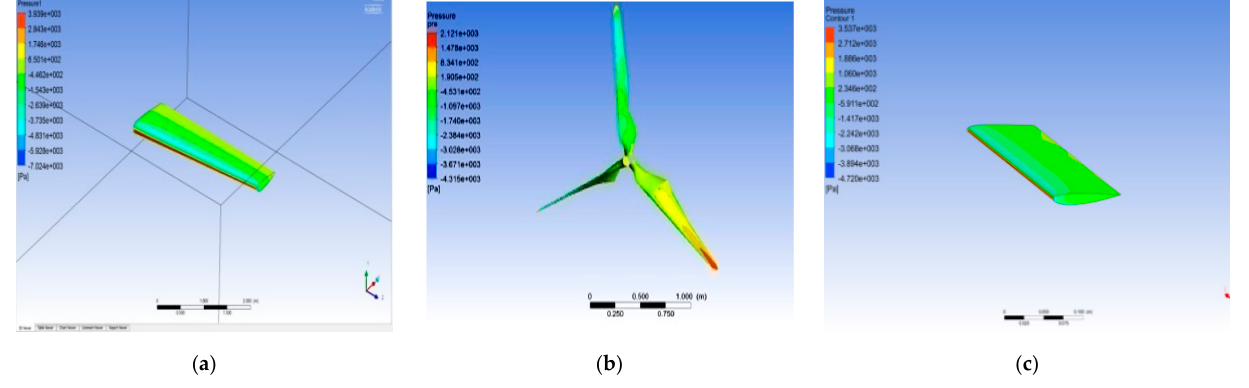
Figure 15. Pressure variations over the airplane wing, wind turbine blade and UAV wing respectively. ( a ) A typical isometric view of pressure variations on airplane wing. ( b ) A typical isometric view of pressure variations on wind turbine. ( c ) A typical isometric view of pressure variations on UAV wing.